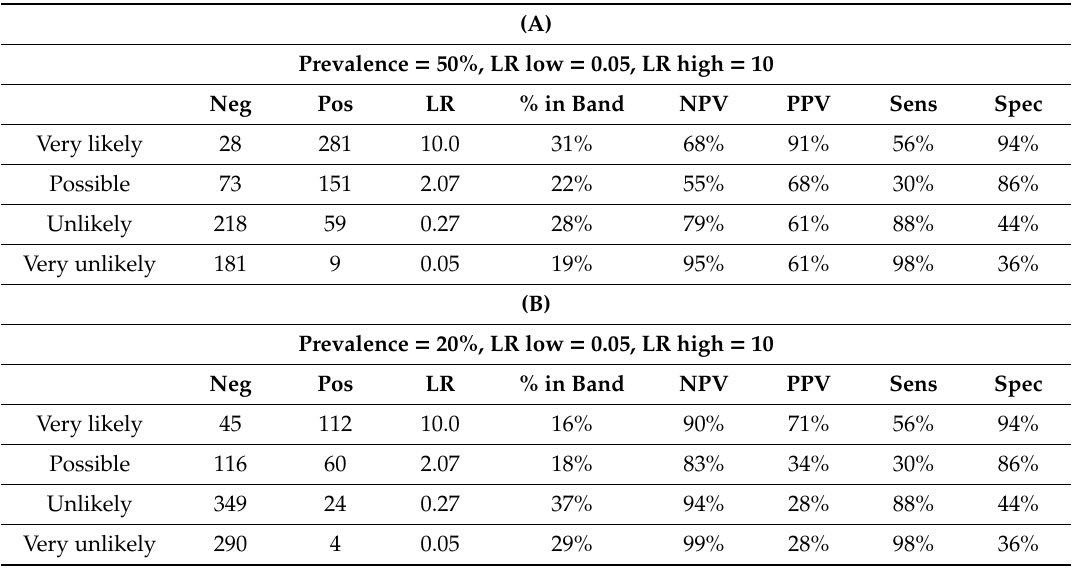
Table 2. Impact of bacterial infection prevalences of 50% ( A ) and 20% ( B ) on the proportion of patients falling into InSep interpretation bands and positive and negative predictive values based on modelled data. We applied a negative likelihood ratio (LR) cuto ff of 0.05 and a positive LR cuto ff of 10, assuming these were clinically